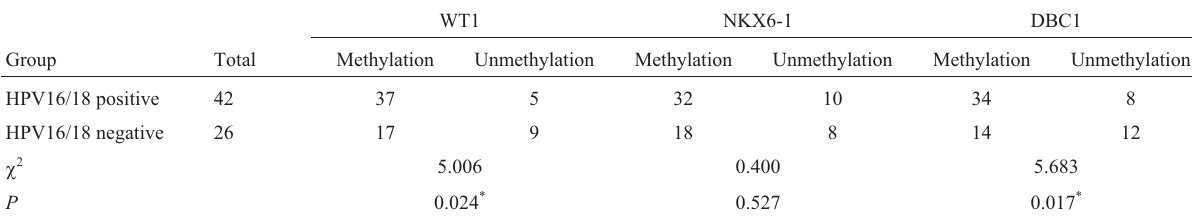
Table 7 - Promoter of gene methylation and HPV16/18 infection distribution in CIN2, CIN3 and cervical cancer tissue. WT1